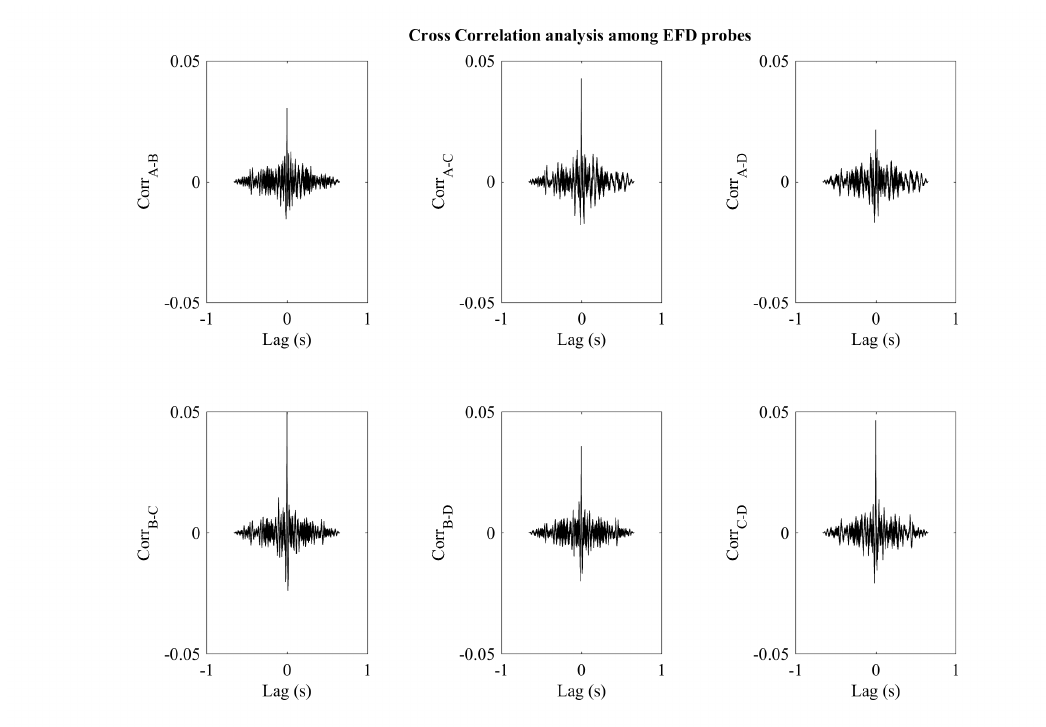
Figure 5. Cross correlation between six couples of probes potentials. The zero lag value represents the null shifting between signals